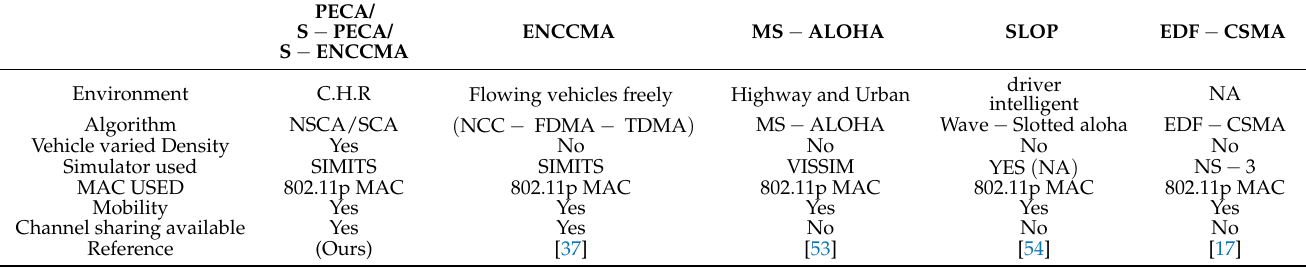
Table 5. State of-art-techniques comparison.